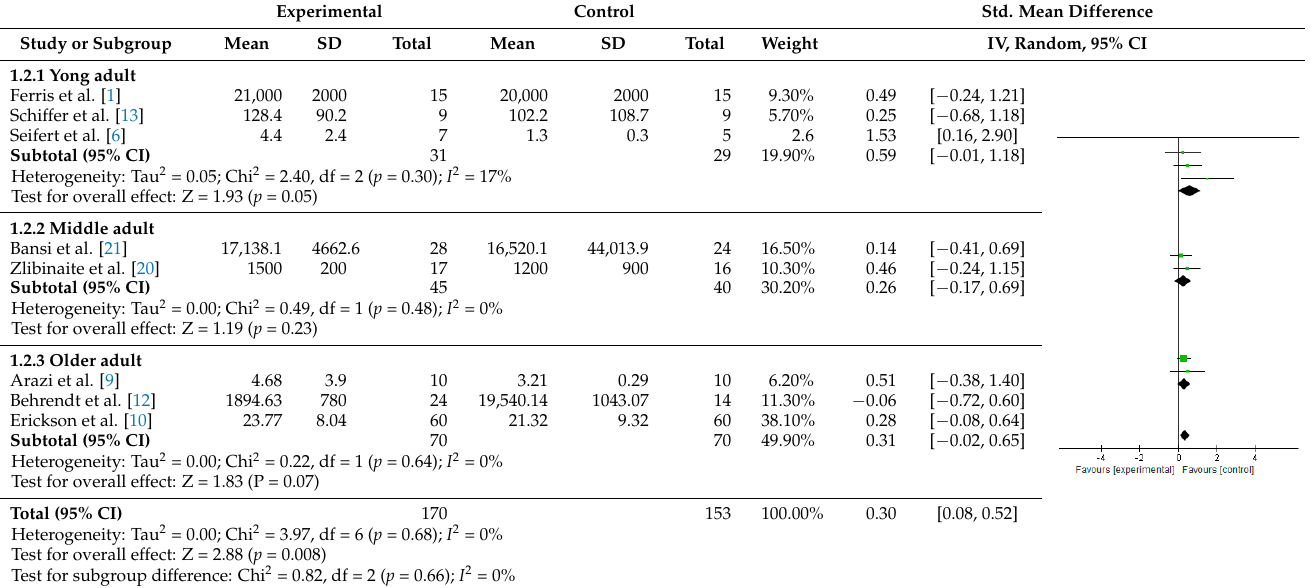
Table 5. Standardized mean differences and forest plot of impact of endurance exercise on BDNF levels in different populations.